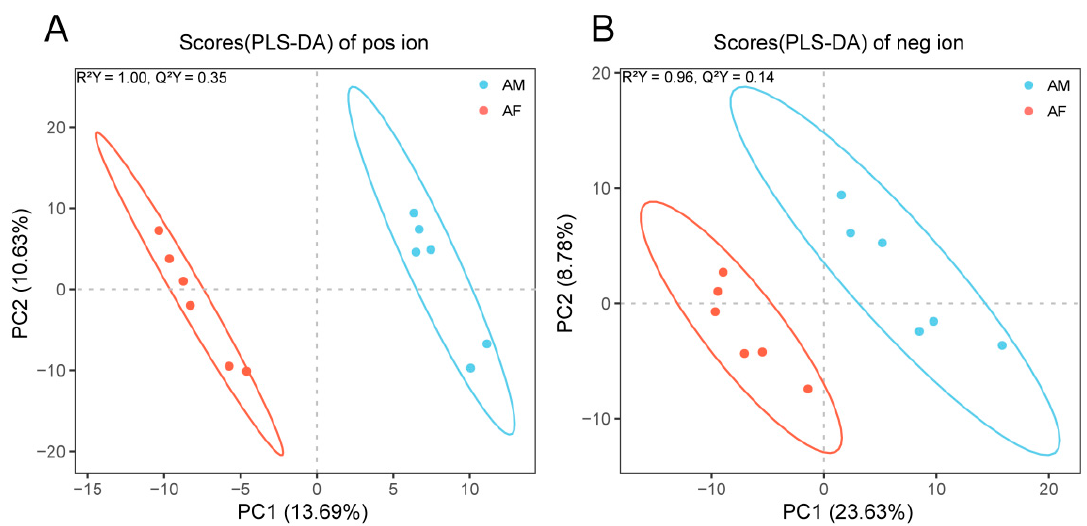
Figure 3. Partial least squares discriminant analysis (PLS-DA) score plots displaying the discrimination of serum metabolomes between adult male and female Chinese alligators in positive ( A ) and negative ( B ) ion modes based on the first two principal components (PCs). AM: adult male; AF: adult female.